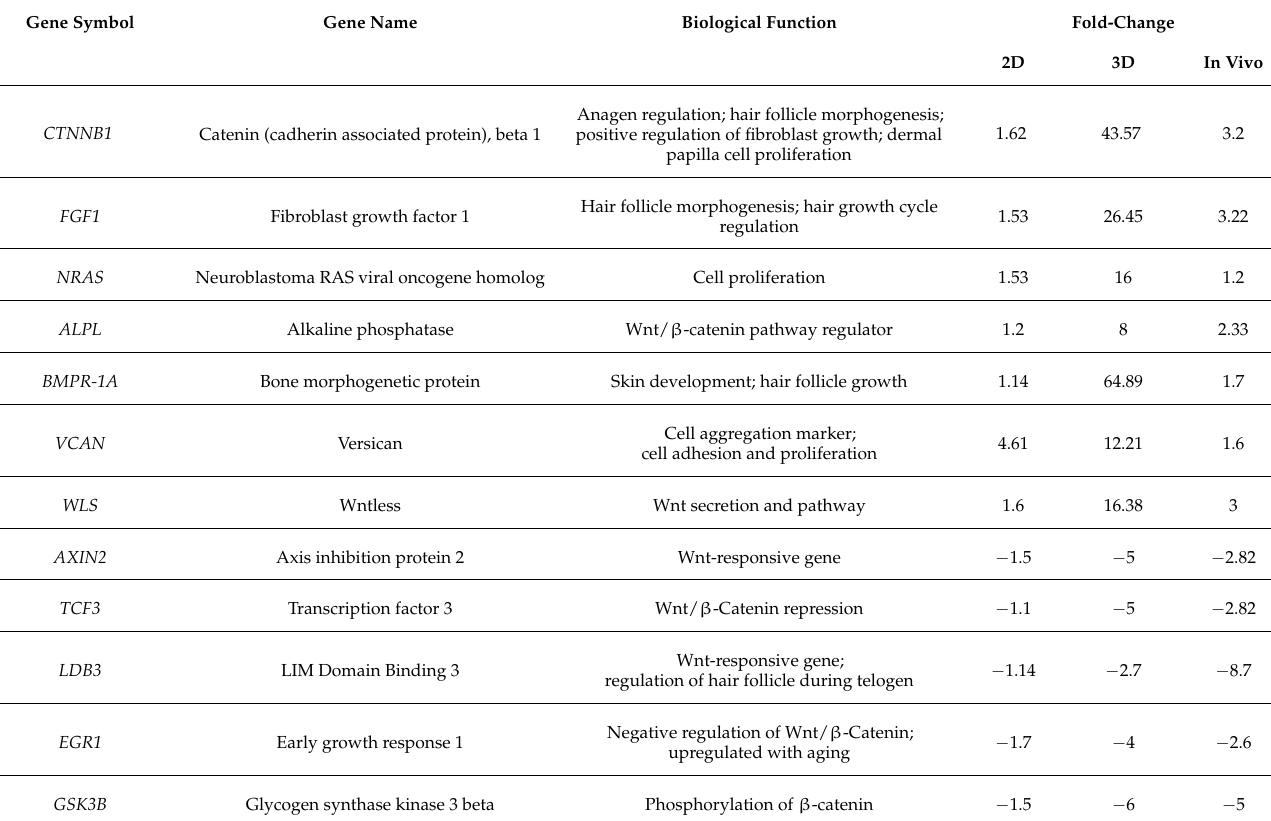
Table 4. Comparison between the TCQA-treated HFDPCs in 2D, in 3D, and in vivo [24]